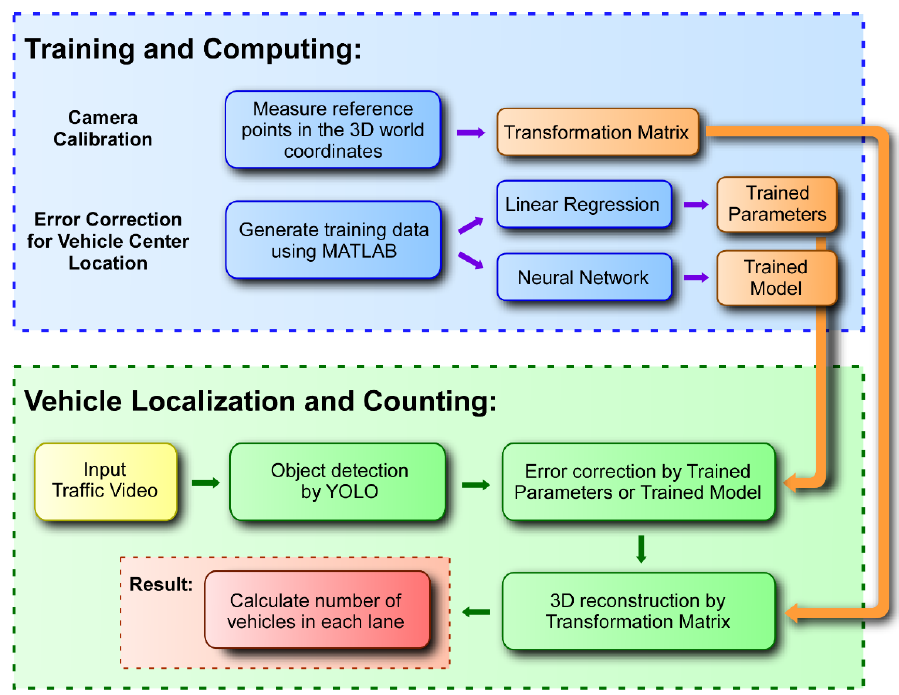
Figure 1. Overall work fl ow of the proposed vehicle localization method.